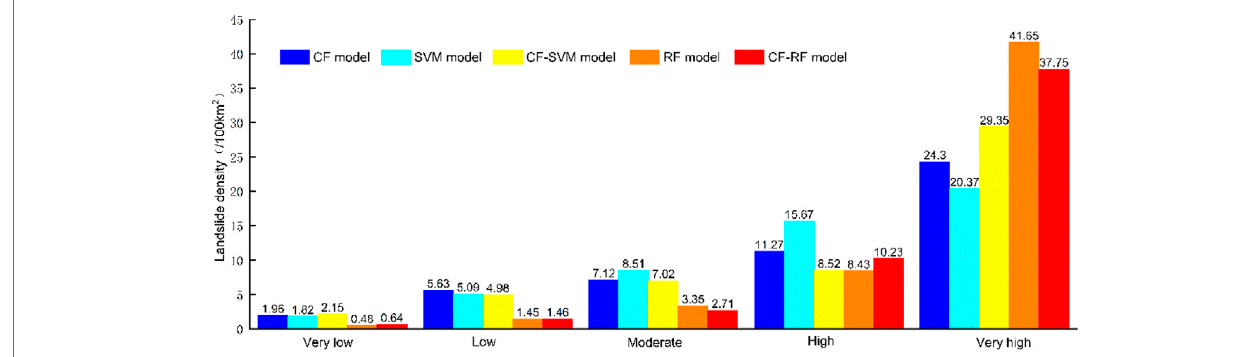
FIGURE 9 | Comparison of the LD of the susceptibility maps from the fi ve models.